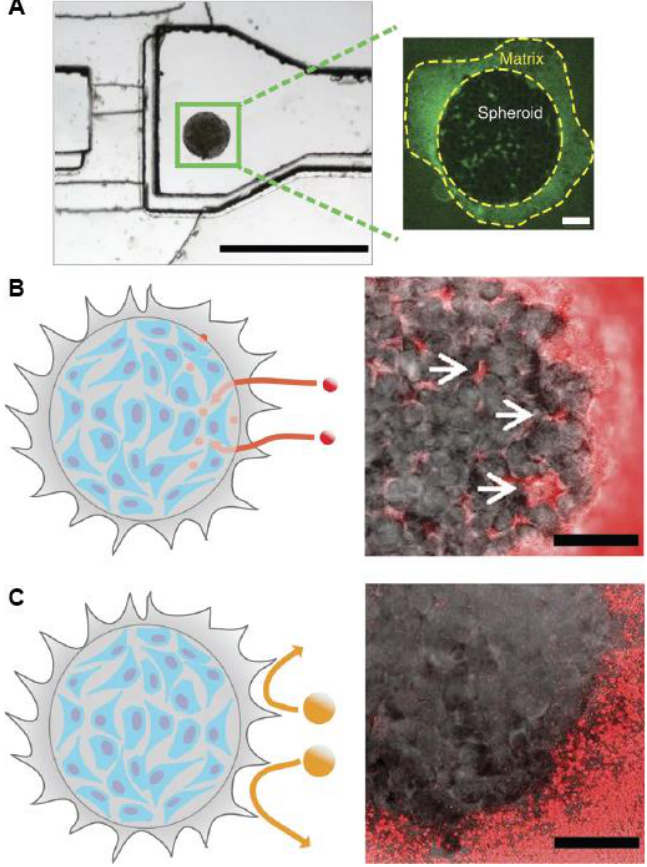
Figure 8. ( A ) Image of the microfluidic device demonstrating the channel dimensions and the immobilized spheroid in the imaging chamber. Scale bar left panel = 1000 μm, right panel = 100 μm. ( B ) Scheme (left) and image (right) of 40 nm fluorescent poly(ethyleneglycol)-coated nanoparticles (PEG-NPs) administered for 1 h at 50 μL h −1 penetrating the spheroid and accumulating in the interstitial spaces (arrows). Scale bar = 100 μm ( C ) Schematic (left) and image (right) of 110 nm fluorescent PEG-NPs administered for 1 h at 50 μL h −1 being not penetrating the spheroid. Scale bar = 100 μm. Adapted from Reference [129], with permission from Nature © 2020.